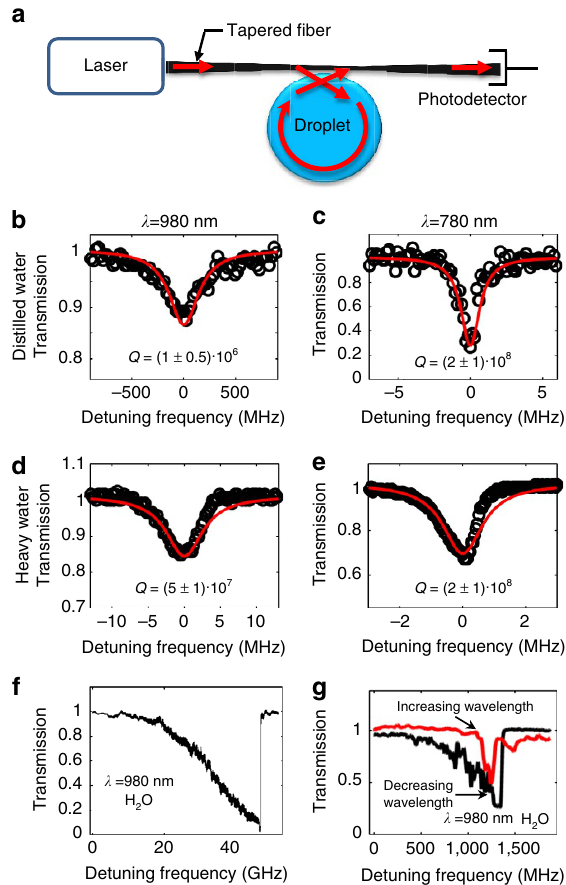
Figure 2 | Optical resonances in micro water droplets. ( a ) Experimental set-up ( b – e ) Monitoring resonator transmission while scanning the wavelength through resonance provides the linewidth. ( f ) Coupling efficiency close to 99% was measured at critical coupling conditions. ( g ) Thermal asymmetry of the resonance linewidth measured from two consequented scans. The droplet’s diameter was between 20 and 40 m m.